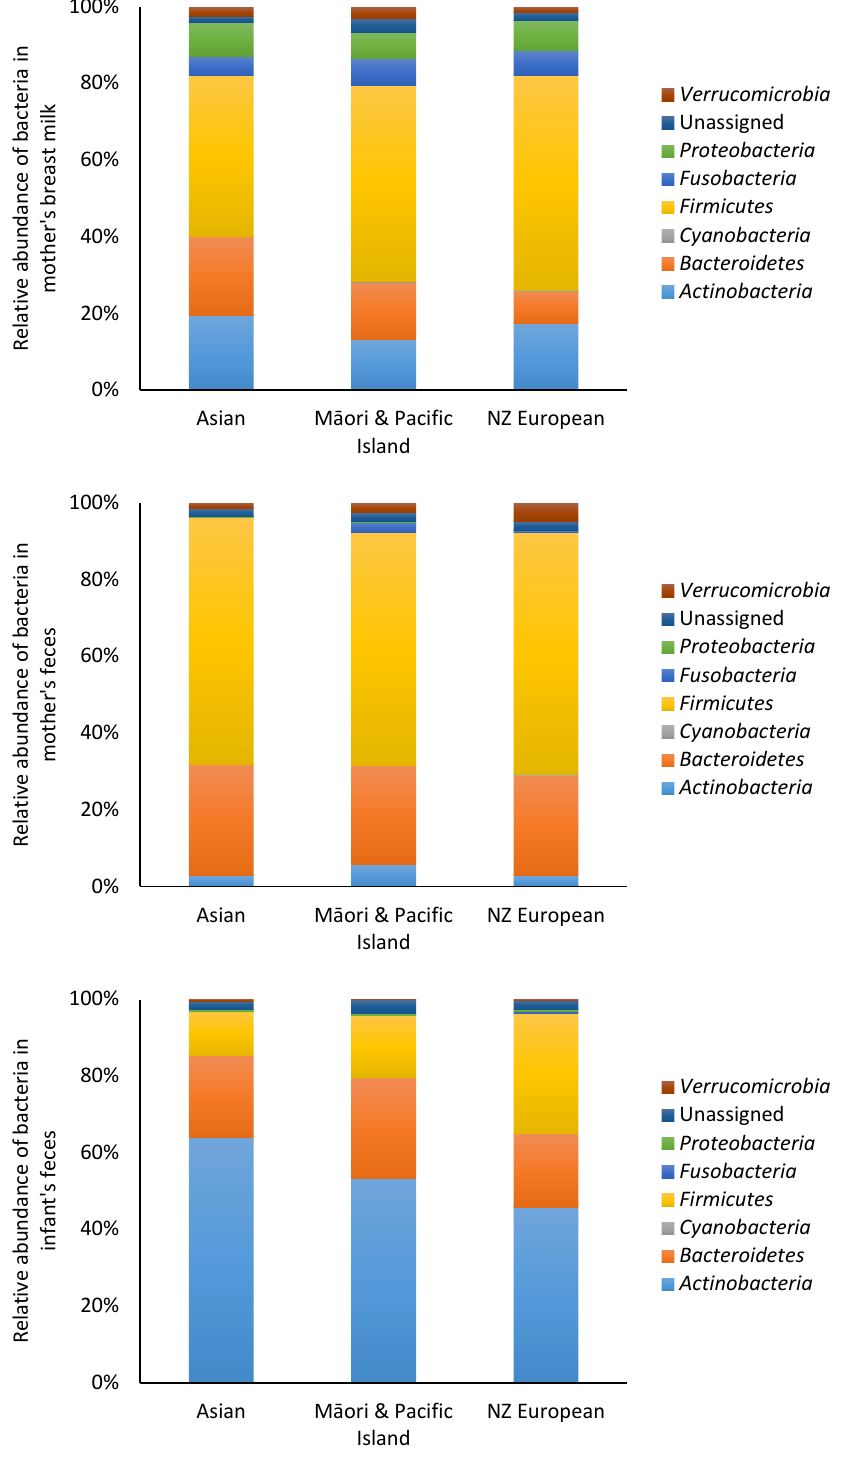
Figure 2. Relative abundance of bacteria at the phylum level in mother and infant. The data were categorized according to the mother’s ethnicity. Table 1. Relative abundance of bacteria at the genus level in breast milk categorized according to the mother’s ethnicity.